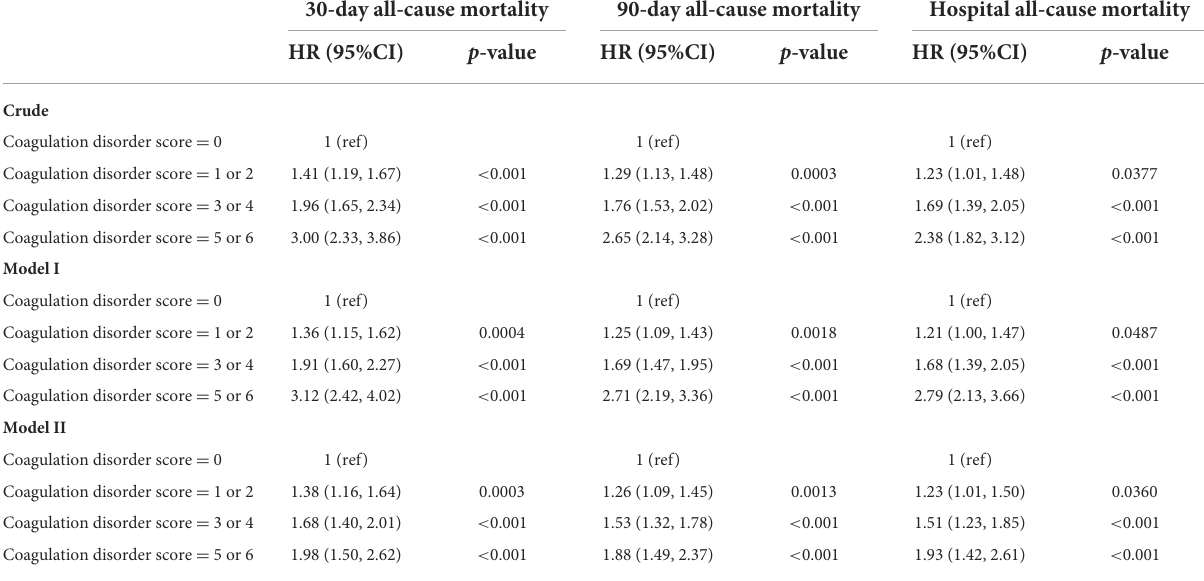
TABLE 3 The Cox proportional hazard model of the coagulation disorder score for predicting short-term all-cause mortality in critically ill patients with CHF. 30-day all-cause mortality 90-day all-cause mortality Hospital all-cause mortality